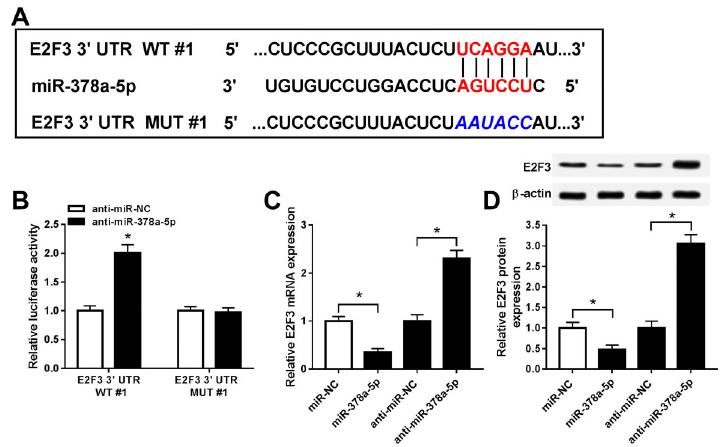
Figure 4. A , The putative binding sites between miR-378a-5p and E2F3 were predicted by Targetscan. B , Luciferase activity of SRA01/ 04 cells co-transfected with E2F3 3 0 UTR WT#1 or E2F3 3 0 UTR MUT#1 and anti-miR-378a-5p or anti-miR-NC was measured via the dual-luciferase reporter system. C and D , The expression of E2F3 mRNA and protein in SRA01/04 cells transfected with miR-NC, miR-378a-5p, anti-miR-NC, and anti-miR-378a-5p was assessed by qRT-PCR and western blot. Data are reported as means ± SD. *P o 0.05 ( t -test or ANOVA). WT: wild-type; MUT: mutant-type; NC: negative